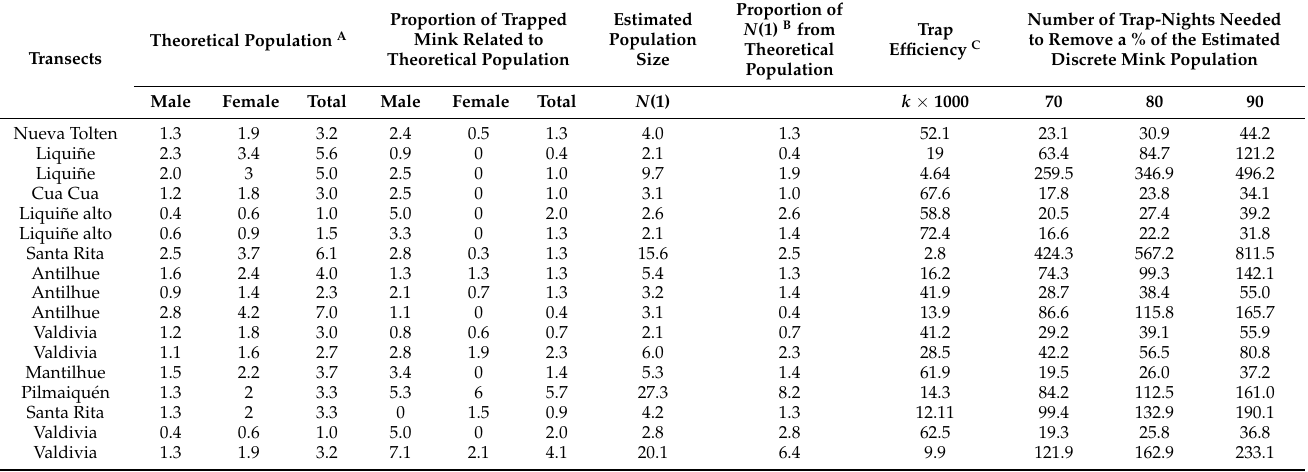
Table 5. Comparison of the discrete estimated population with discrete theoretical population (see Medina-Vogel et al. [41] and effort needed to remove 70%. 80% and 90% of the